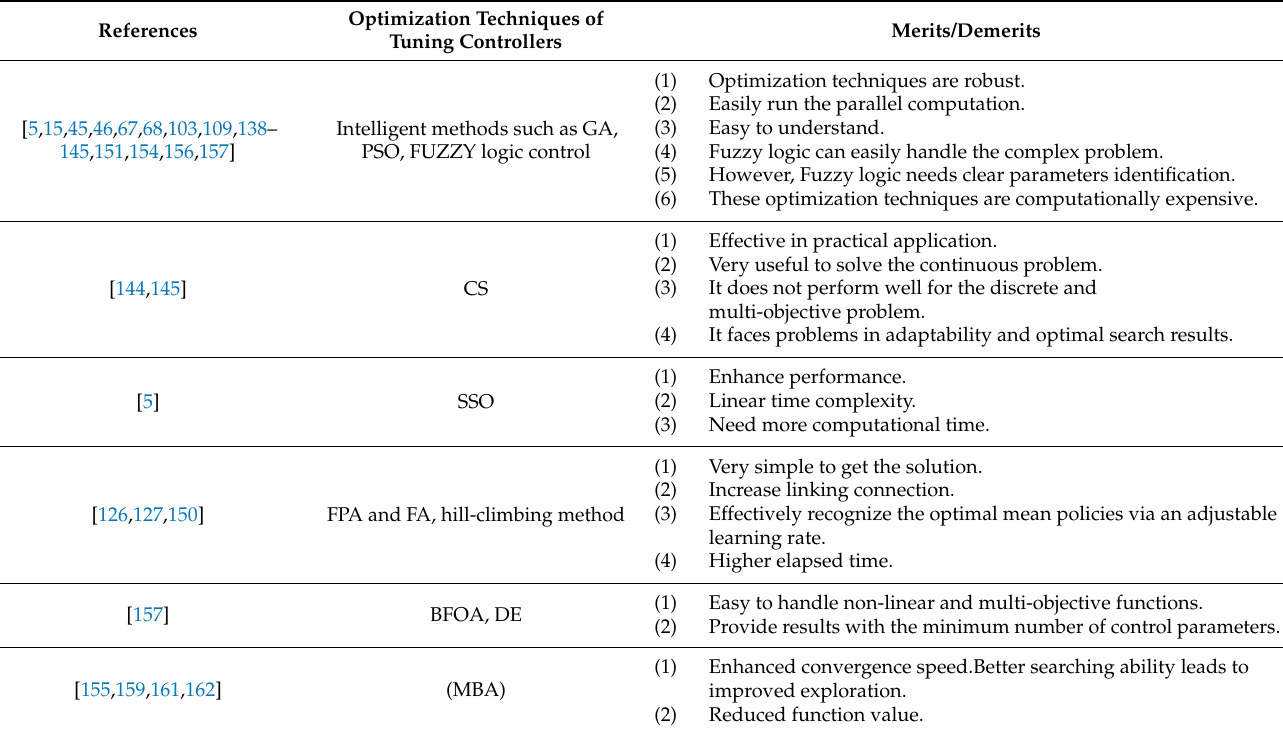
Table 3. Optimization techniques with merits and